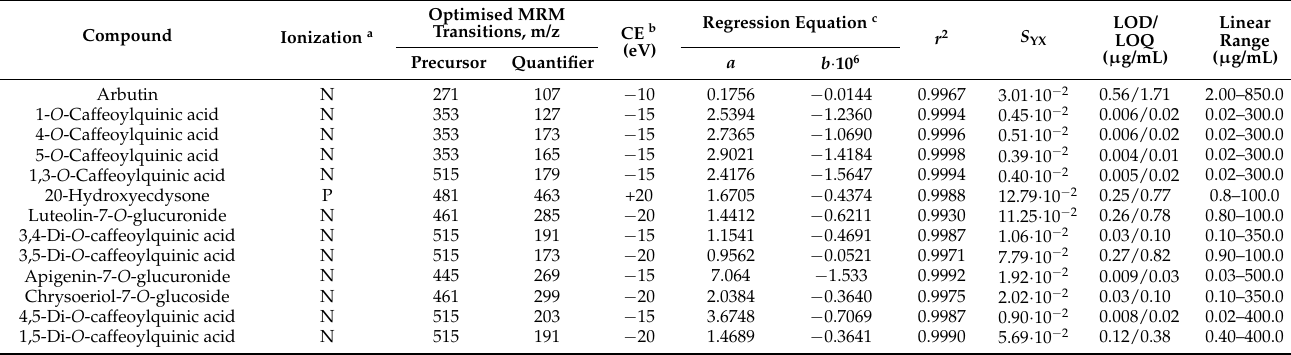
Table 7. Regression equations, correlation coefficients ( r 2 ), standard deviation ( S YX ), limits of detection (LOD), limits of quantification (LOQ) and linear ranges for 13 reference standards.